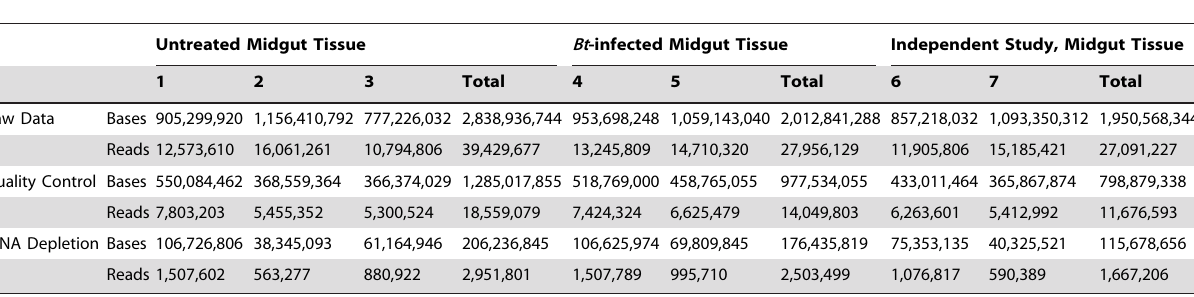
Table 3. Impacts of quality filtering and rRNA depletion on resultant RNA-Seq dataset sizes.